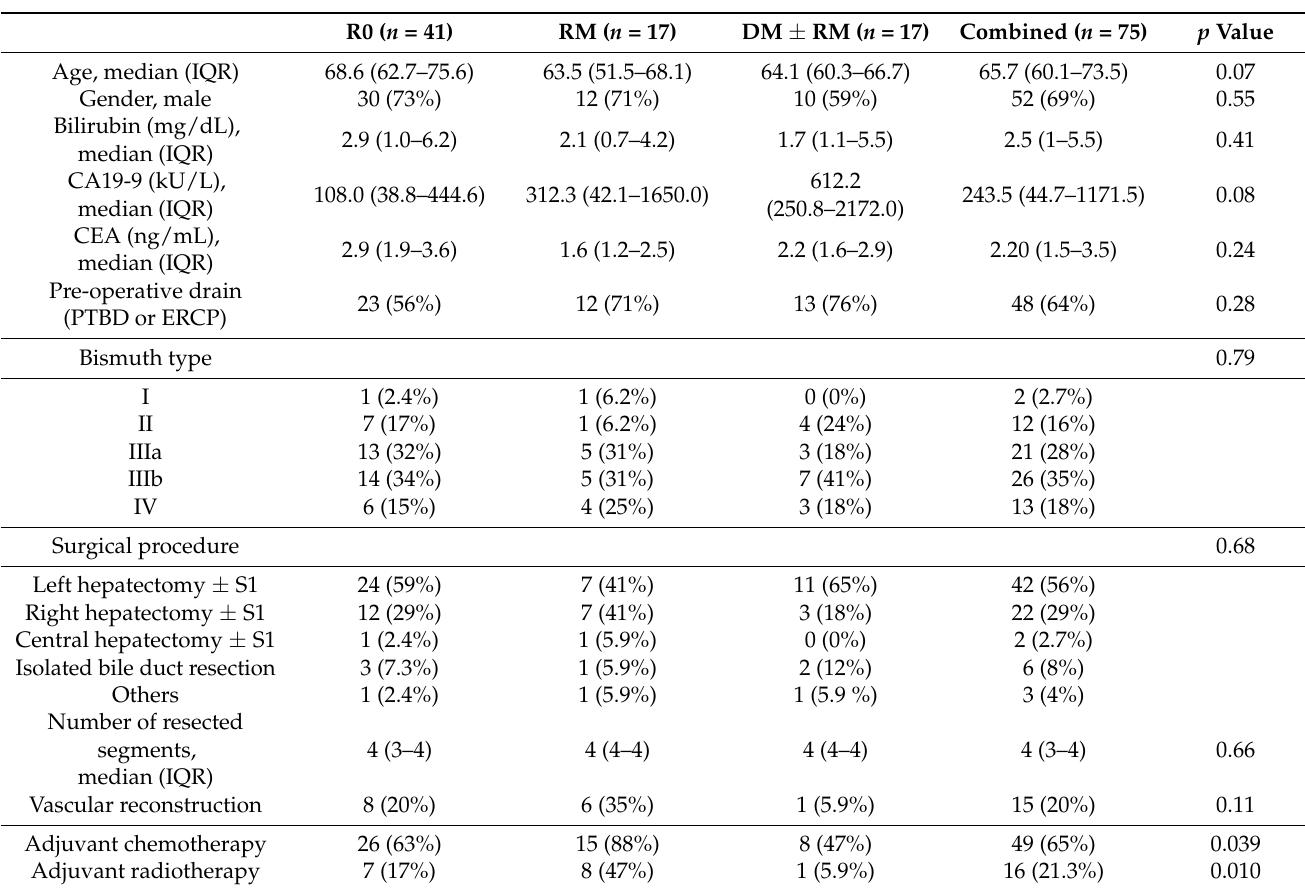
Table 1. Patients’ characteristics and surgical